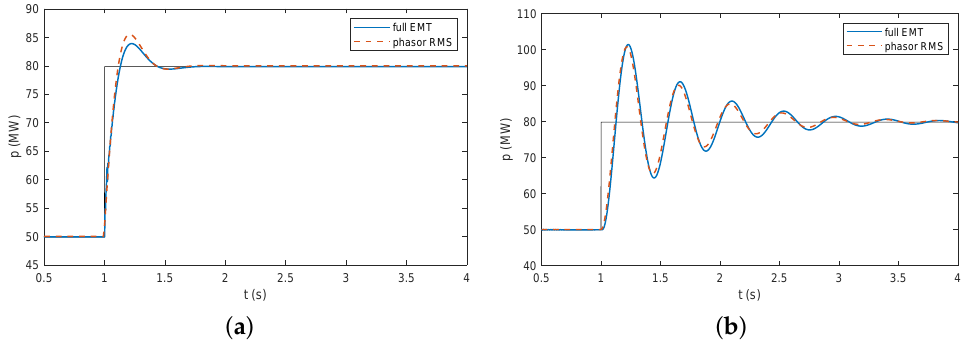
Figure 5. Comparison and validation of phasor RMS and full EMT models for a step change in the active power reference: ( a ) grid-following; ( b ) grid-forming.